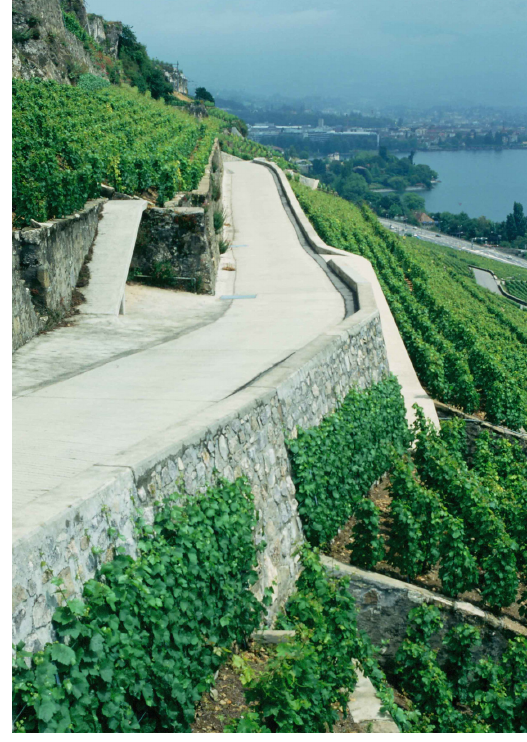
Figure 2. Vinyard of the Lausanne City Farm (Switzerland), near the Leman lake.